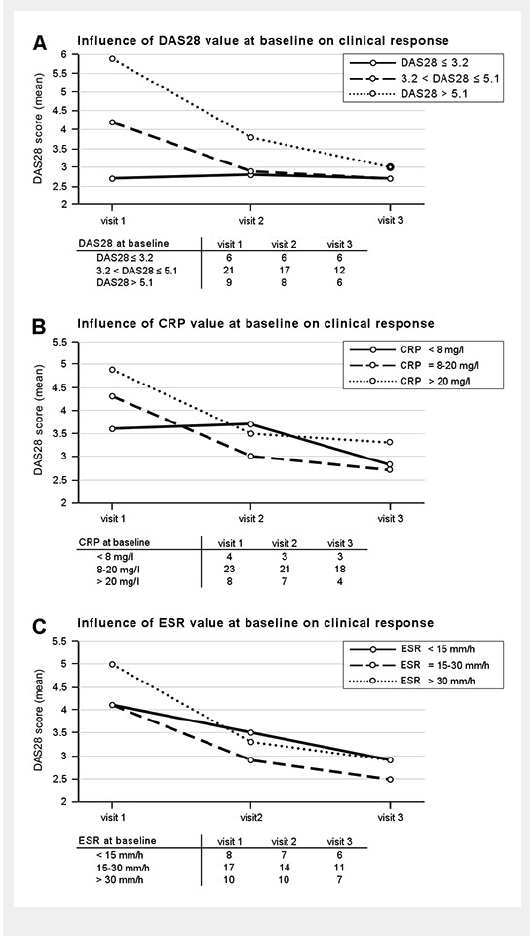
Clinical response over time depending on A) disease activity, B) CRP, and C) ESR values at baseline. The numbers of patients with available assessments at baseline and subsequent visits are listed in the tables. CRP, C-reactive protein; ESR, erythrocyte sedimentation